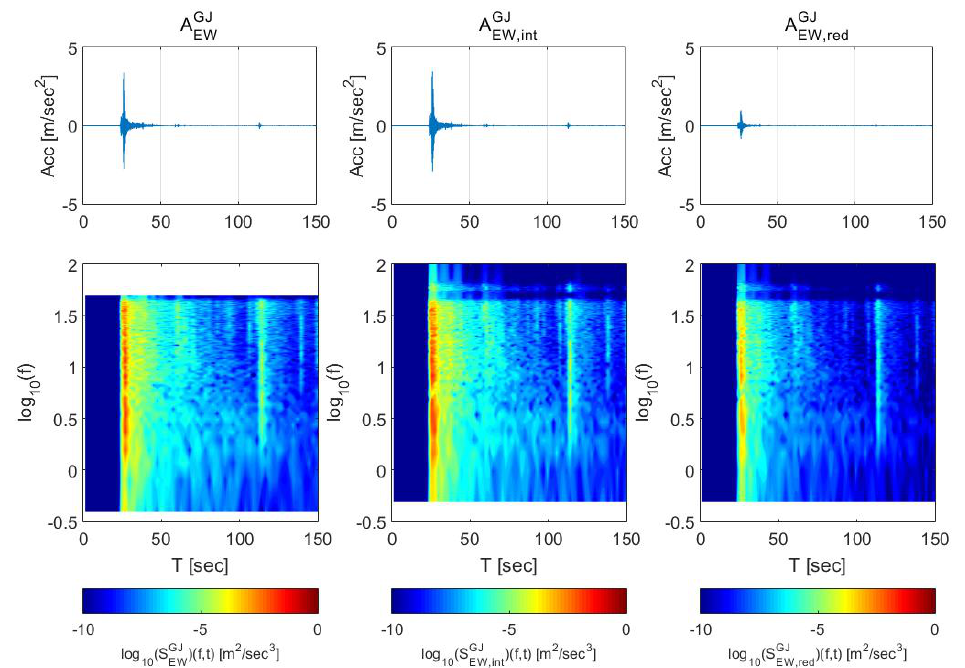
Figure 5. Gyeongju earthquake data adjustment — original data (100 Hz), interpolated data (500 Hz), and scaled data (max 1 m/s 2 ), from the left.